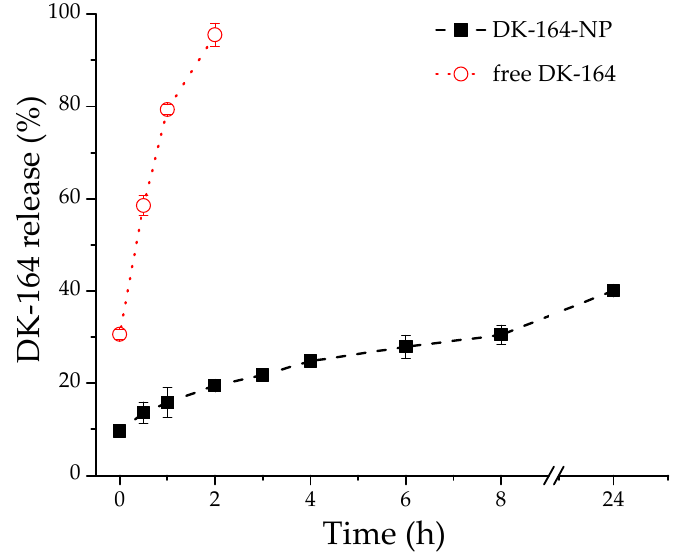
Figure 3. Release profile of DK164 from NPs in PBS with 10% ethanol solution at 37 ◦ C (black line). The red line refers to the diffusion of pure DK-164 (applied as ethanol solution) through the membrane. Each point represents average ± SD (n = 3), and the lines are just a guide for the eye.